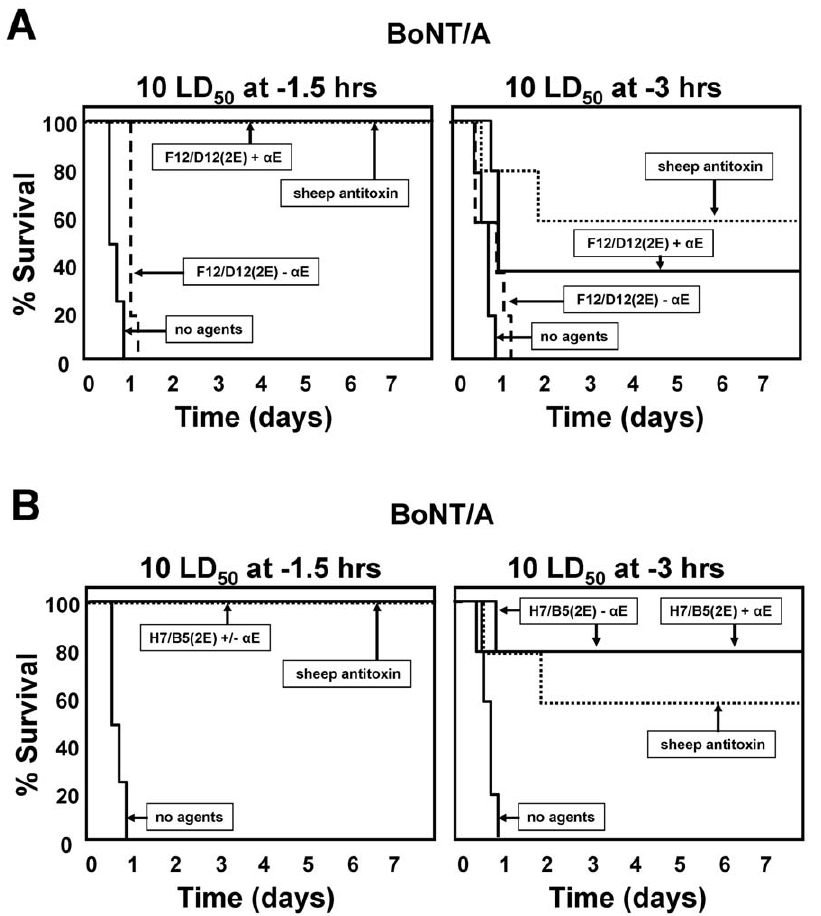
Figure 5. BoNT/A intoxication is prevented by administering a single anti-BoNT/A VHH heterodimer in a clinically-relevant post- intoxication mouse model. A 10 LD 50 dose of toxin was administered by intraperitoneal injection either 1.5 or 3 hours prior to intravenous administration of antitoxin agents as indicated. Symptoms of BoNT/A intoxication and lethality were monitored following post-intoxication administration of double-tagged heterodimers of neutralizing or non-neutralizing anti-BoNT/A VHHs + / 2 clearing Ab. The time to death is plotted as % survival as a function of time following administration of toxin. Time to death for mice given no agents or the positive control sheep antitoxin are also shown. ( A ) The double-tagged heterodimer consisted of two non-neutralizing VHHs, ciA-F12 and ciA-D12 (F12/D12(2E)) and was administered with or without anti-E-tag clearing mAb ( a E) as indicated. ( B ) The double-tagged heterodimer consisted of two BoNT/A neutralizing VHHs, ciA-H7 and ciA-B5 (H7/B5(2E)) and was administered with or without anti-E-tag clearing mAb ( a E) as indicated.